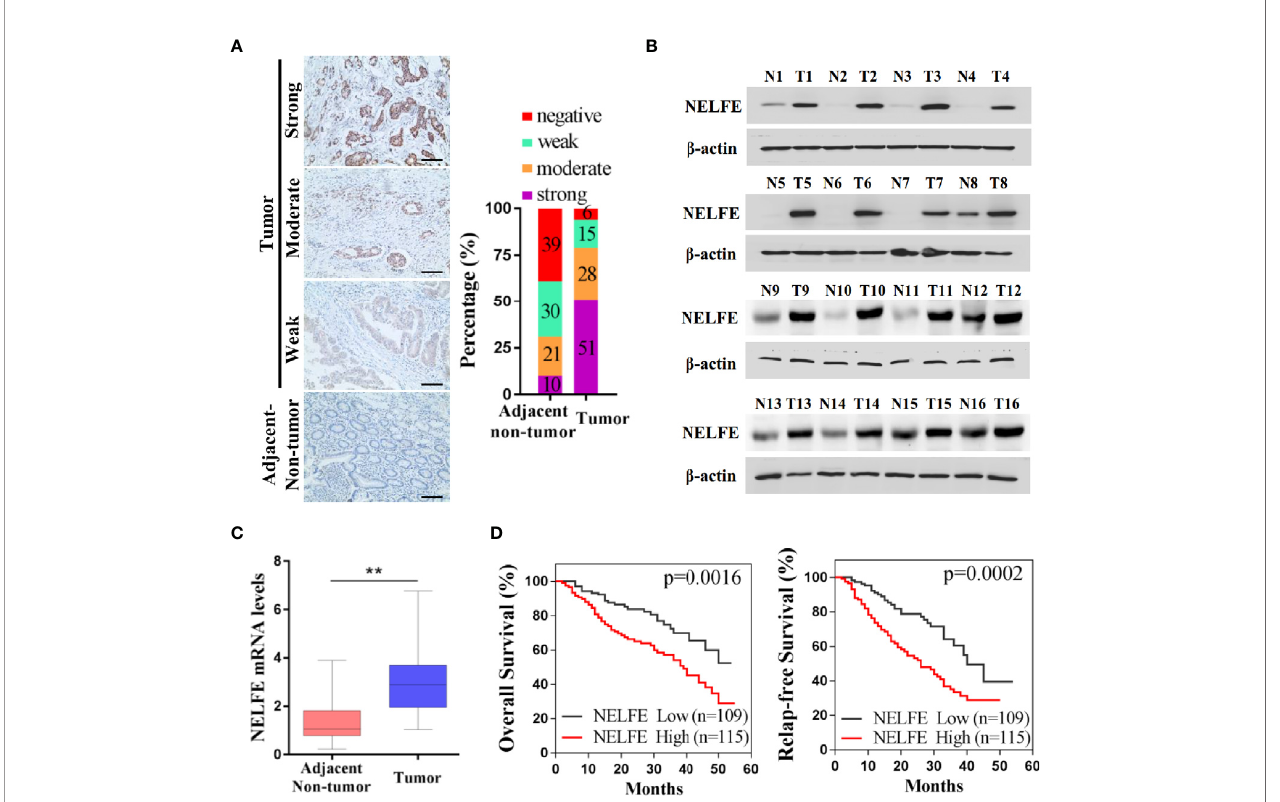
FIGURE 1 | NELFE was overexpressed in gastric cancer and associated with poor survival rates in gastric cancer patients. (A) The expression levels of NELFE in 236 pairs of gastric cancer tissues and normal gastric tissues were examined by immunohistochemical staining. (B, C) The expression levels of NELFE in 32 pairs of fresh tumor tissues and adjacent nontumor tissues were detected by western blotting and qRT-PCR. (D) The overall survival (OS) rates and relapse-free survival (RFS) rates in gastric cancer patients with high NELFE expression and low NELFE expression were analyzed by Kaplan-Meier curves. **P <